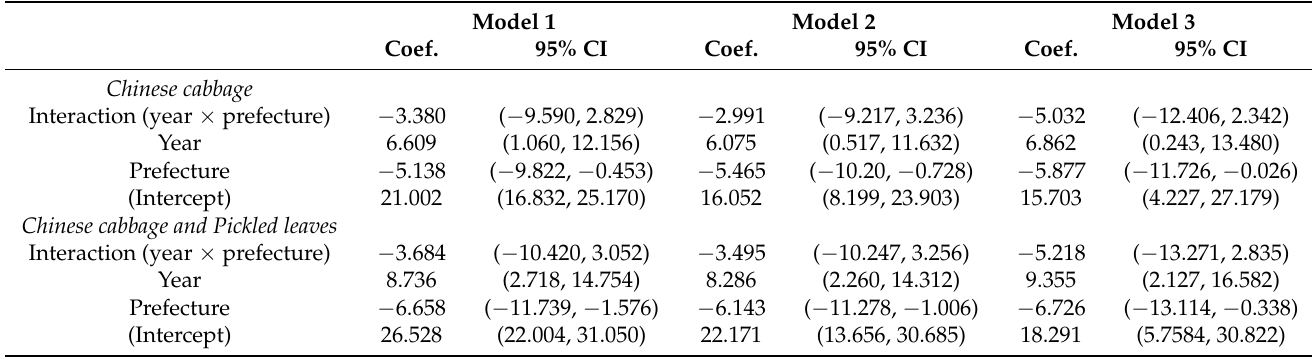
Table 3. Interaction of year and prefecture on Chinese cabbage